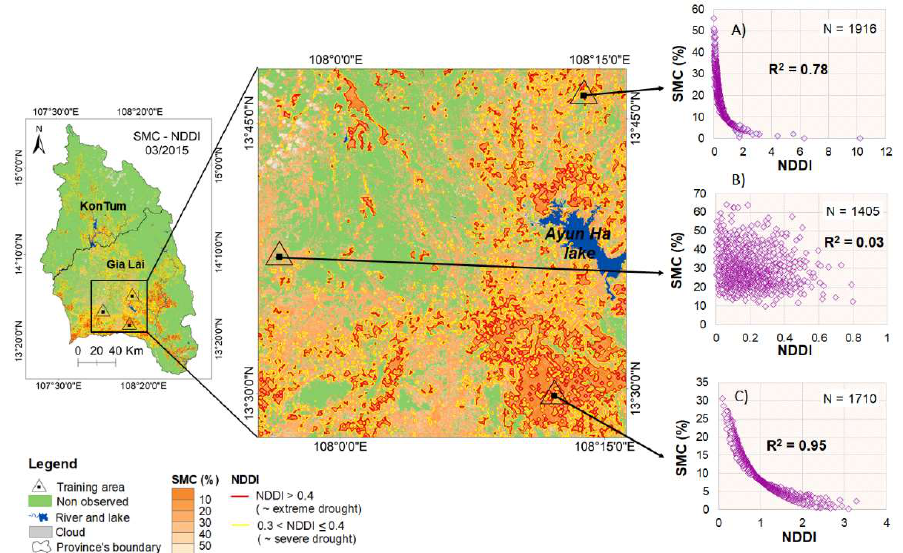
Figure 11. Map of the retrieved NDDI-overlaid estimated SMC from L8 images acquired over the northern part of the Central Highlands of Vietnam in March 2015, which demonstrates the spatial relationship between these two variables: ( A ) within the area, 20–30% is dense vegetation coverage; ( B ) within the area, more than 40% is dense vegetation coverage; ( C ) within the area with lower than 20% dense vegetation coverage.